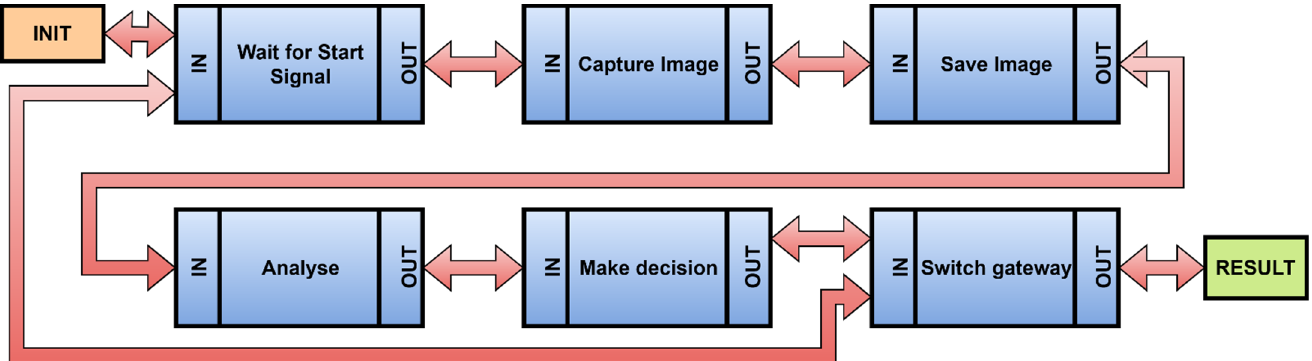
Figure 20. A workflow of the IIoT device.